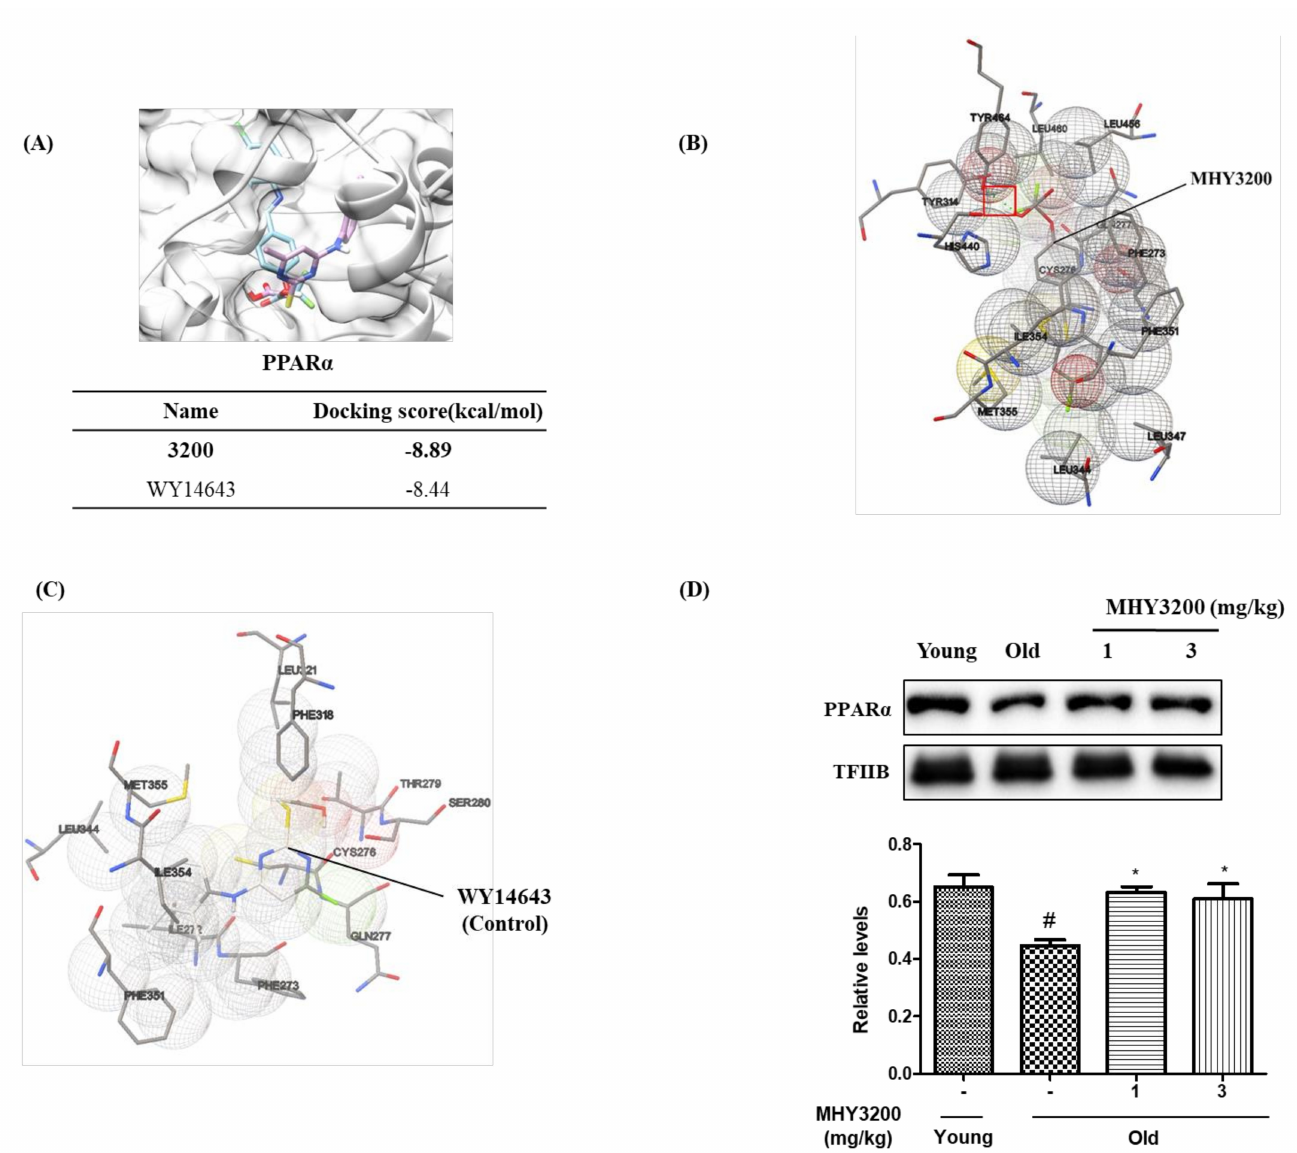
Figure 4. Binding affinity between MHY3200 and PPAR α and its effects on PPAR α activity during aging. Docking simulation was performed to identify the interaction between MHY3200 and PPAR α and the ligand binding affinity was assessed. ( A ) MHY3200 has similar binding affinity to the known PPAR α agonist, WY14643. ( B ) MHY3200 interacts with PPAR α via multiple interactions involving several residues, including a single hydrogen bond (shown in the red square). ( C ) The control compound WY14643 also interacts with PPAR α via multiple residues but does not form a hydrogen bond. ( D ) Levels of PPAR α protein in the nucleus. TFIIB was used as an internal nuclear control and graphs were quantified with CS analyzer image analysis software. One representative blot is shown from three independent experiments in each group that yielded similar results ( n = 6). One-way analysis of variance (ANOVA) was used to determine the statistical result: # p < 0.05 vs. Young rats; * p < 0.05 vs. Old rats. Young (-), non-treated young rats; Old (-), non-treated old rats; 1, MHY3200 (1mg/kg)-treated old rats; 3, MHY3200 (3mg/kg)-treated old